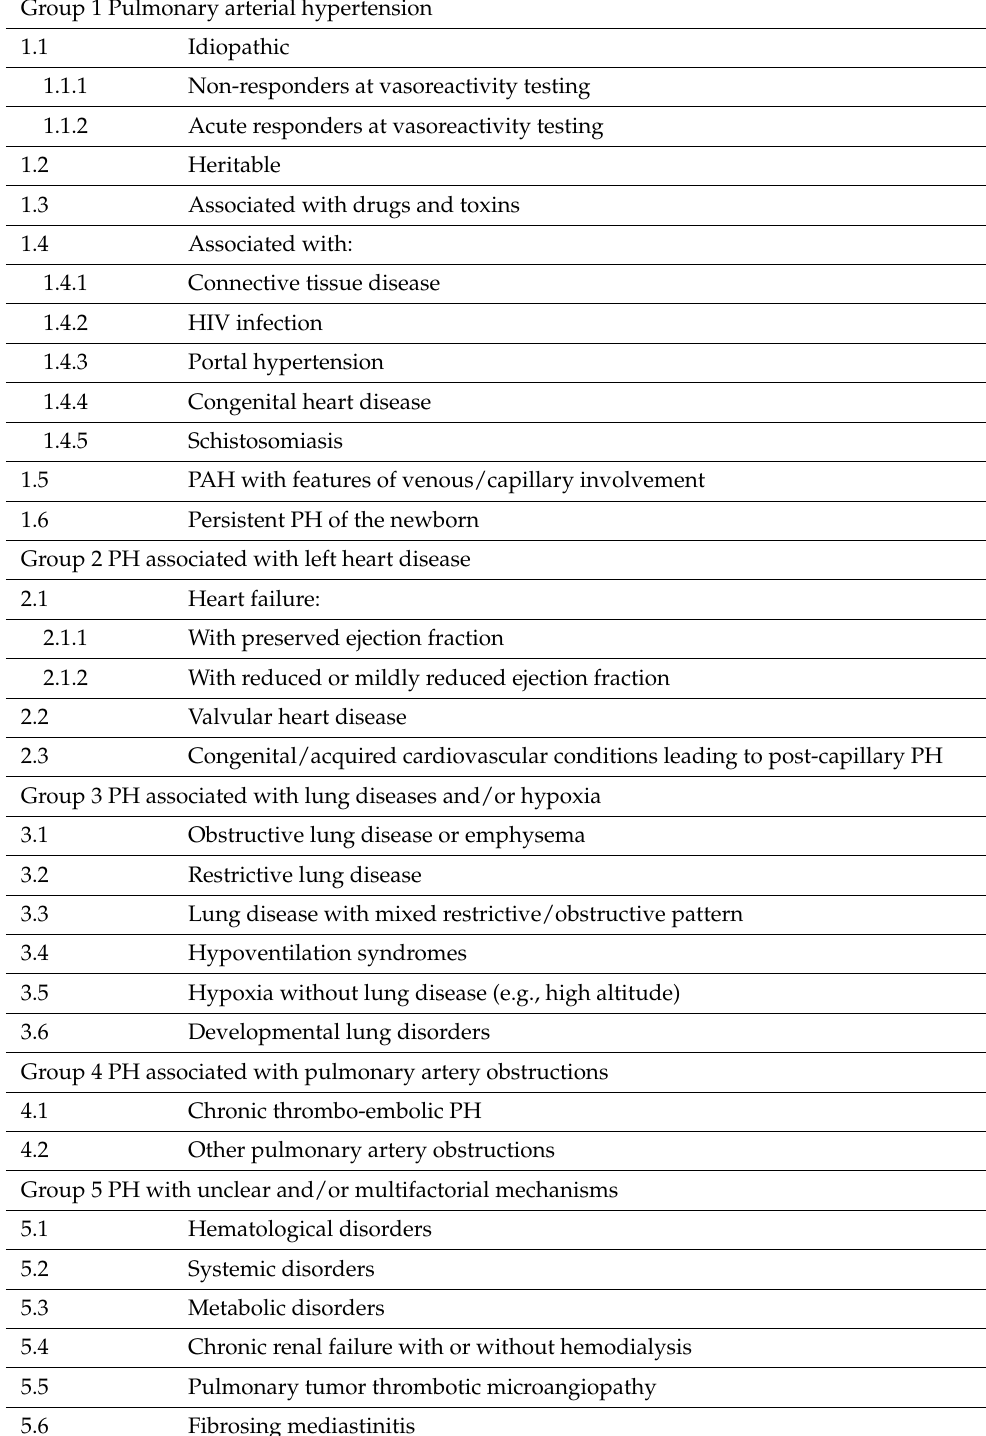
Table 1. Clinical classification of pulmonary arterial